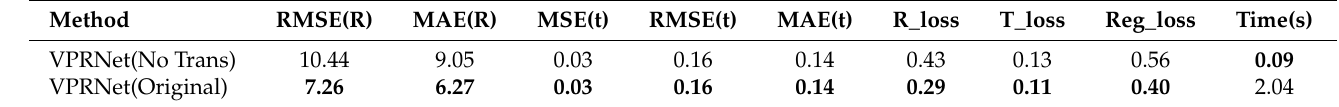
Table 5. The results of the network without Transformer and original network on unseen category data. Bold numbers are the smallest in the current column, and represent the best performance.